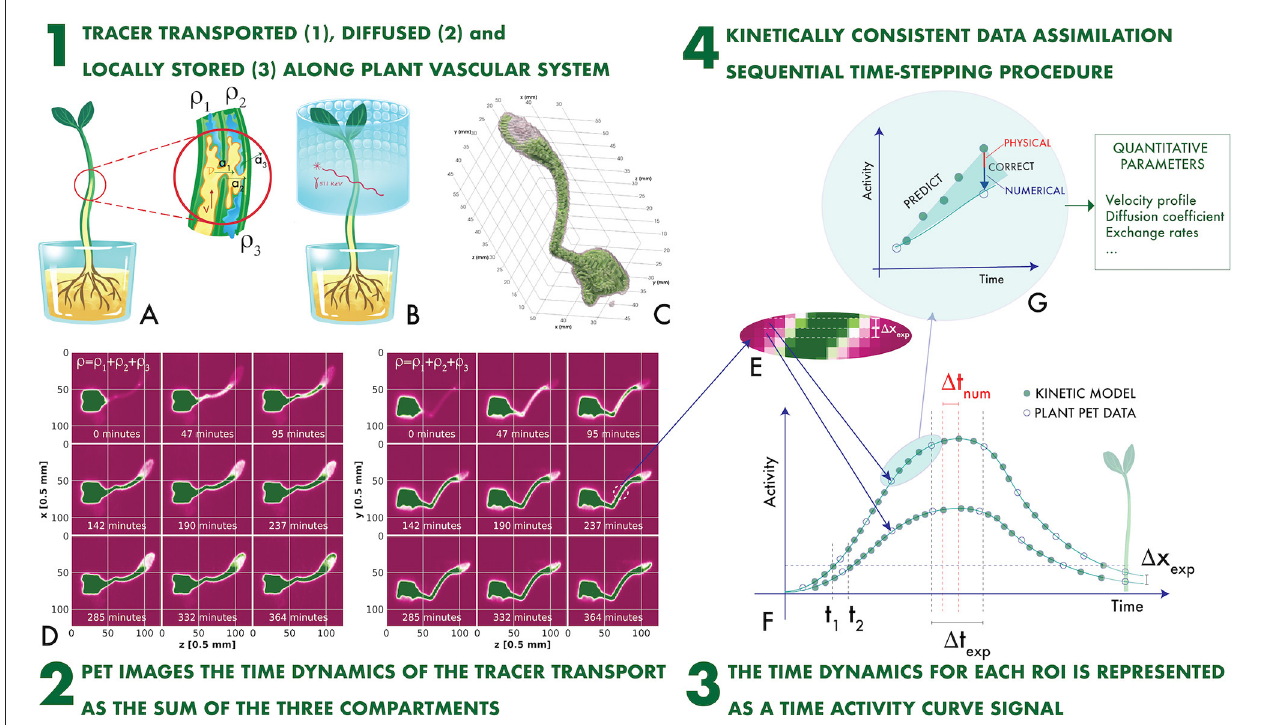
FIGURE 1 | The plant PET imaging technique (A–F) and the novel proposed concept of Kinetically Consistent Data Assimilation KC-DA digital signal processing for quantitative plant PET imaging (F,G) : the tracer transported, diffused and locally stored along the plant vascular system (1) generates time-changing 3-dimensional maps (2). The change in time of the measured activity at a given region of interest along the stem defines the Time Activity Curve (TAC) signal (3), which is modeled with a time stepping prediction-correction algorithm based on a set of novel fluid dynamic equations for the data-driven extraction of physically-driven kinetic parameters